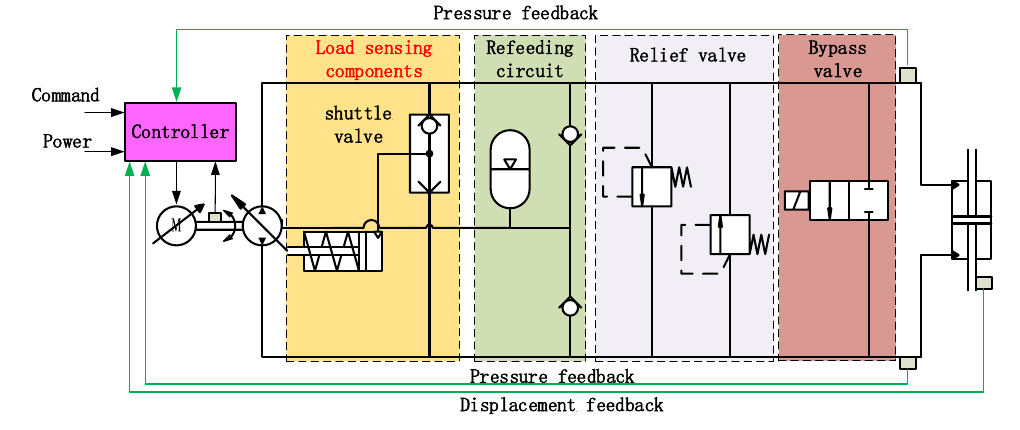
Figure 3. DLS-EHA schematic.